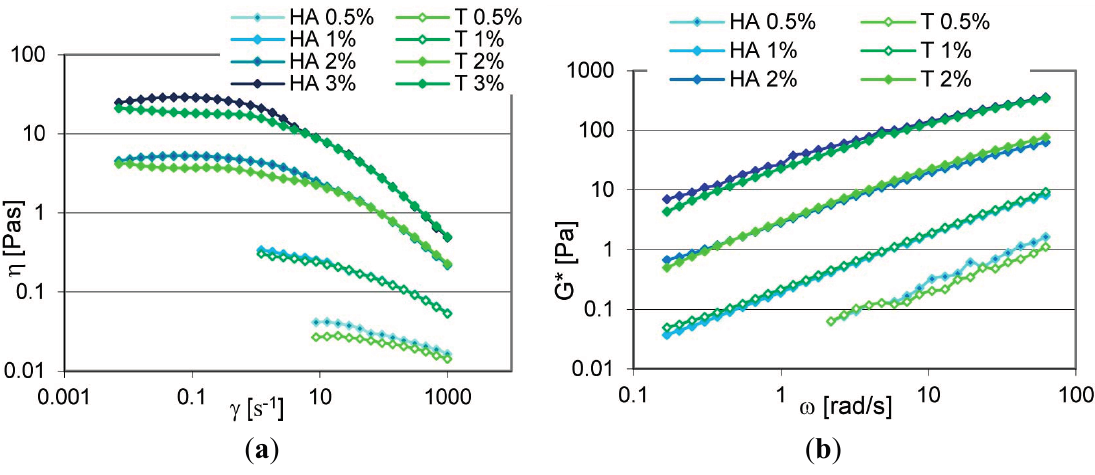
Figure 2. ( a ) Viscosity trends vs . shear rate; and ( b ) G* trends as a function of the frequency of TSP and HA aqueous dispersions at different